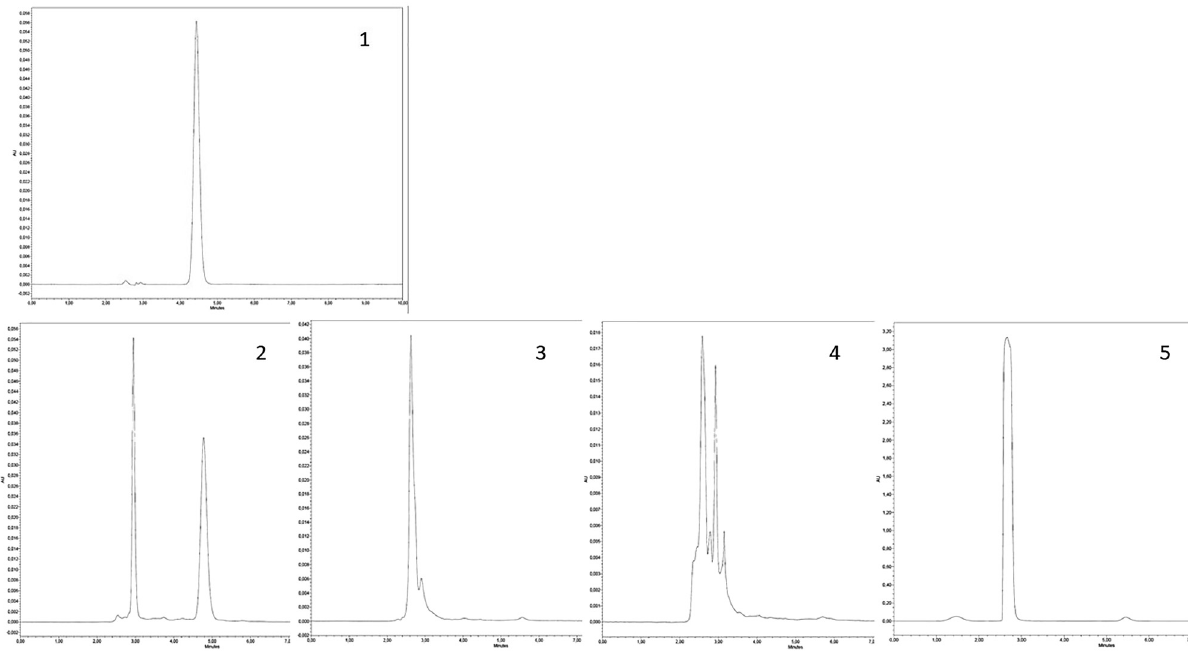
Figure 1: HPLC chromatogram (detection wavelength 230 nm) of Epinephrine tartrate CRS 0.02 mg/mL undegraded (1), degraded by heating (2), by acidi fi cation with 1 M HCl (3), by alkalization with 1 M NaOH (4), by oxidiation with H2O2